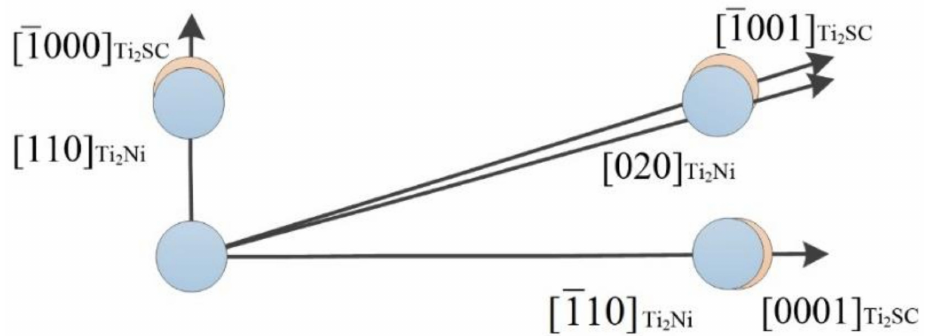
Figure 9. The crystallographic relationship between (0110) Ti 2 SC and (001) Ti 2 Ni. Table 8. The calculated lattice mismatch between Ti 2 SC and Ti 2 Ni. Matching